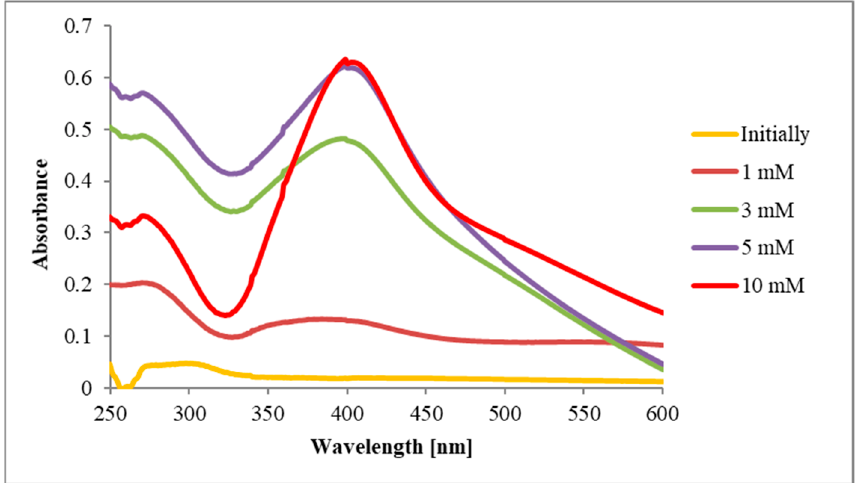
Figure 1. The influence of different AgNO 3 concentrations (1 mM, 3 mM, 5 mM, and 10 mM) on AgNPs-H 2 O formation.